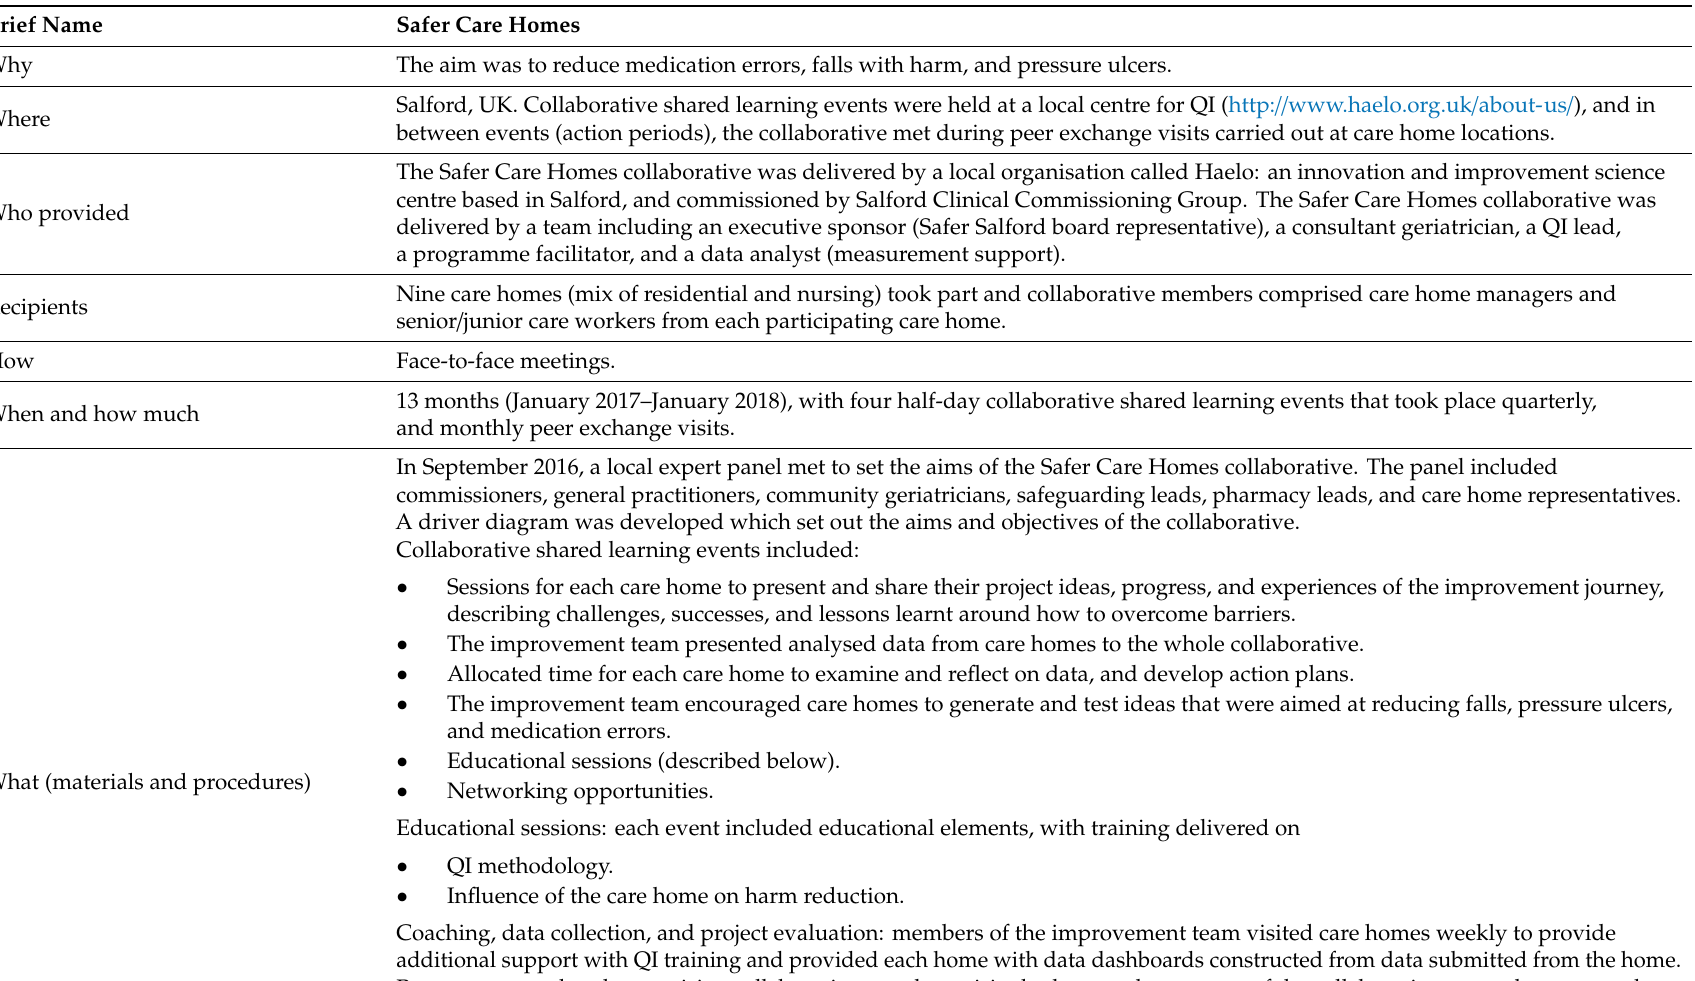
Table 2. Description of the Safer Care Homes Quality Improvement